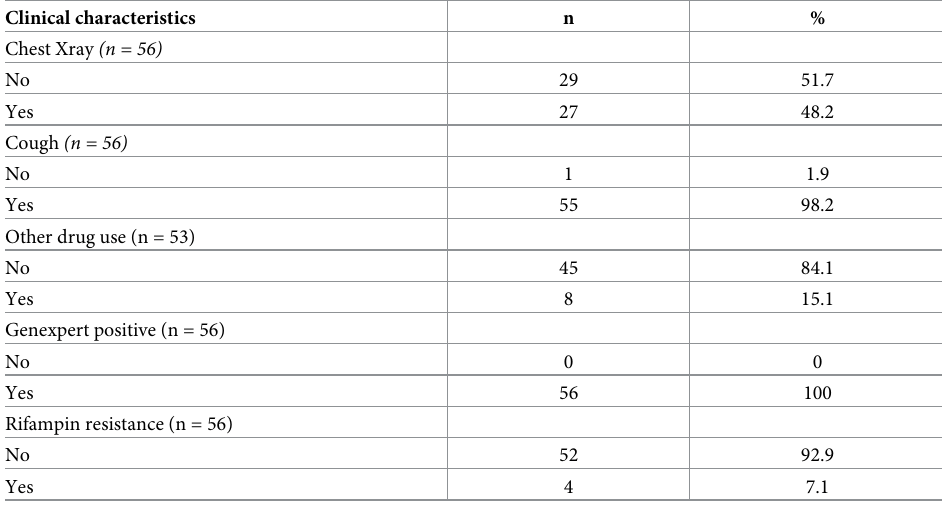
Table 2. Showing the clinical characteristics of the active TB patients. Clinical characteristics